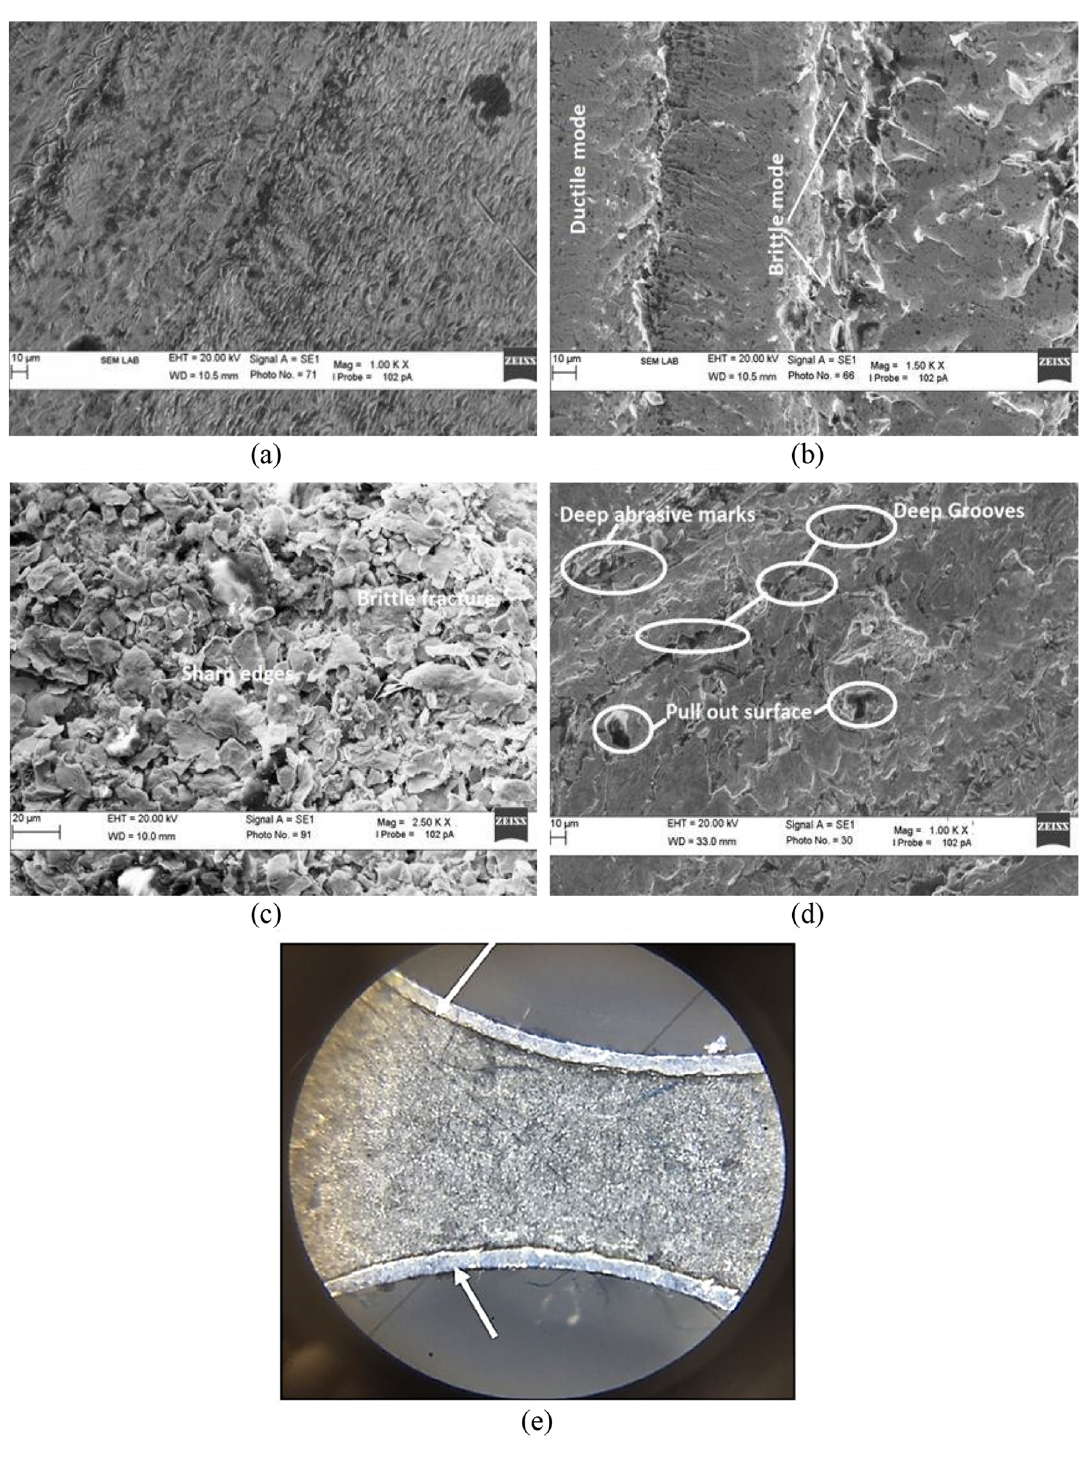
Figure 13. Micrograph of ( a ) Inconel 718 (prior to machining), ( b ) and ( c ) higher surface roughness specimen ( d ) minimum surface roughness specimen, ( e ) hole edge